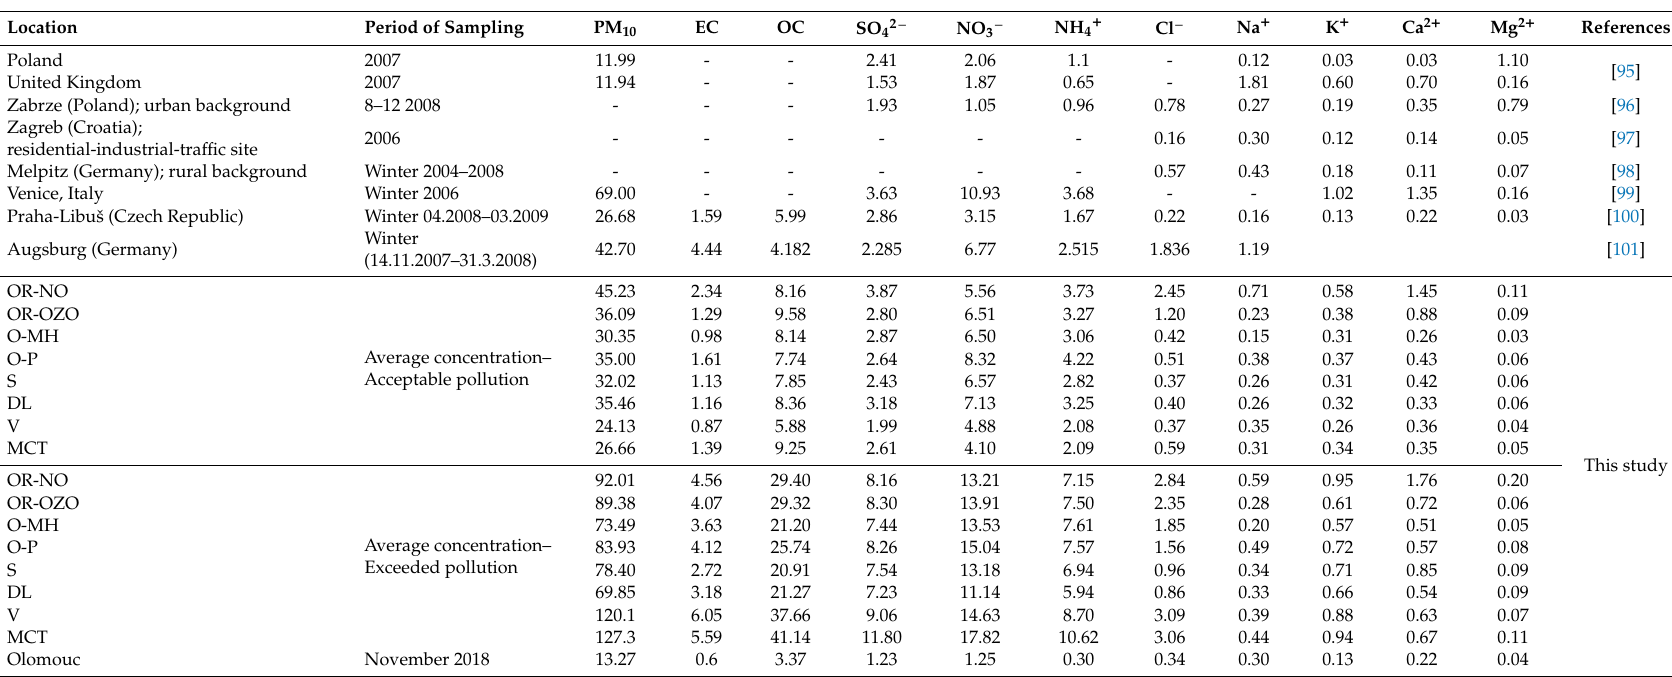
Table 3. Comparison of concentrations of inorganic aerosols and other water-soluble ions in dust particles in the atmosphere of European cities ( µ g / m 3 ).